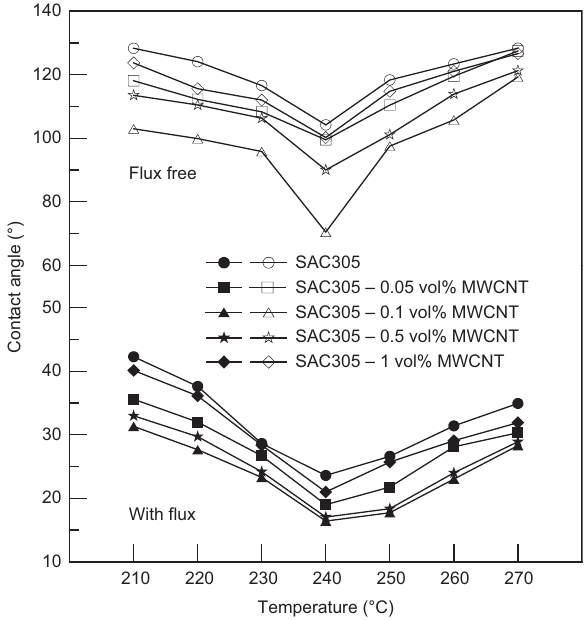
Figure 2 Contact angle as a function of temperature for MWCNT- reinforced composite solders on copper substrate.